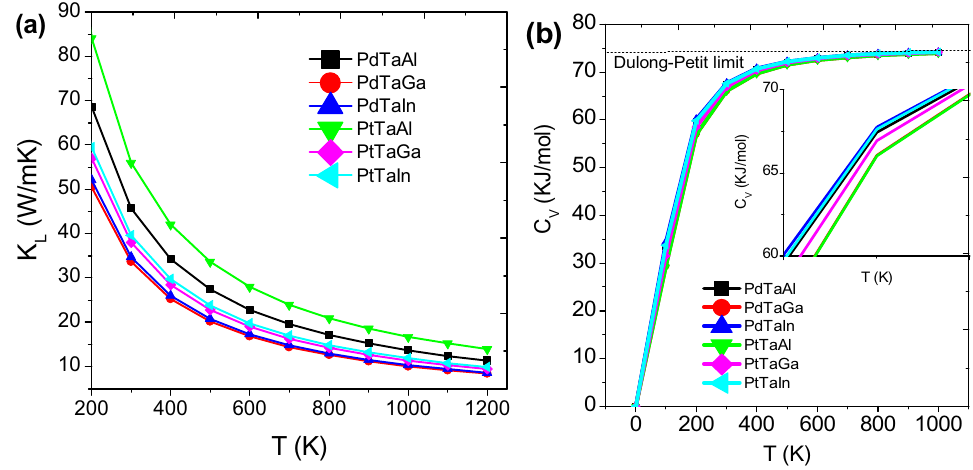
Figure 8. ( a ) Lattice thermal conductivity ( κ L ) and ( b ) Specific heat capacities of XTaZ compounds as a function of